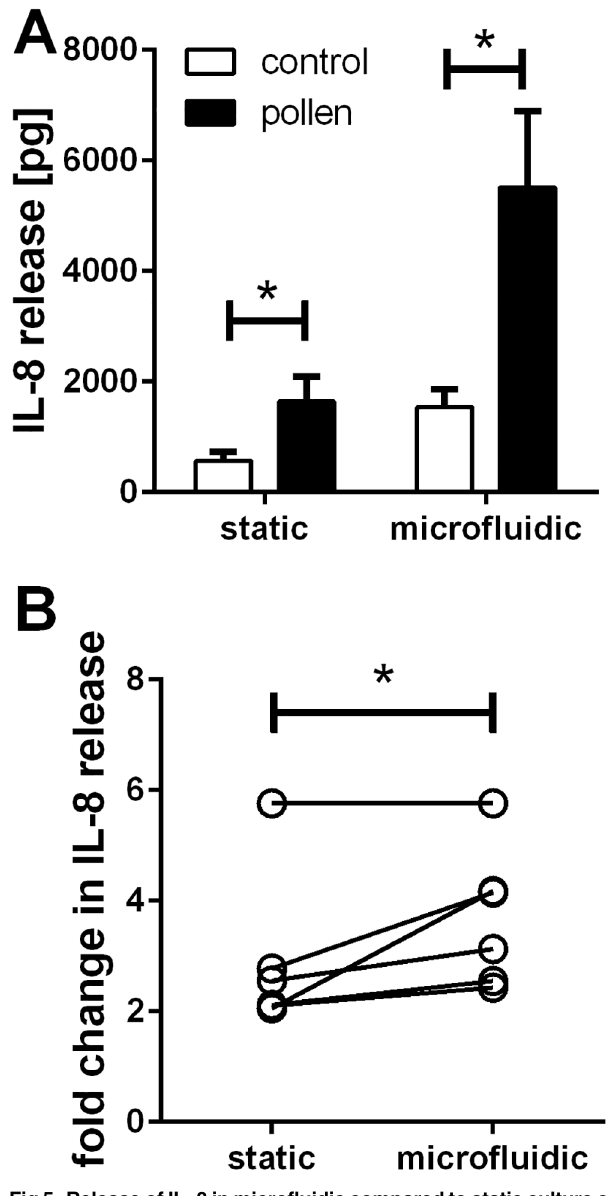
Fig 5. Release of IL – 8 in microfluidic compared to static culture conditions. Basolateral release of IL – 8 by differentiated PBECs after challenge with pollen was analysed by ELISA. n = 6 independent experiments using 5 different donors. a: Overall amount of IL – 8 released by differentiated PBECs in a period of 24h after pollen treatment. b: Comparison of pollen induced IL – 8 release in static and microfluidic culture condition. The x-fold change in pollen induced IL – 8 release compared to untreated control is shown. Linked data points represent experiments run in static and microfluidic culture conditions in parallel with matching PBEC donor. * : p (cid:1) 0.05